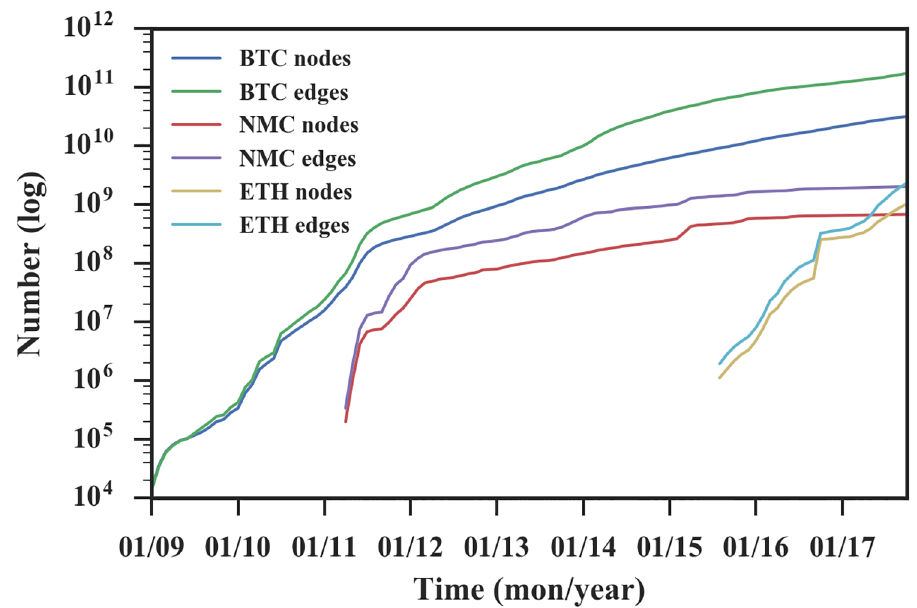
Fig 2. The size of accumulated transaction networks with respect to various cryptocurrencies in log coordinate. The number of nodes and edges are used to represent the size of networks. The three networks have similar growth pattern with rapid growth first and slower growth